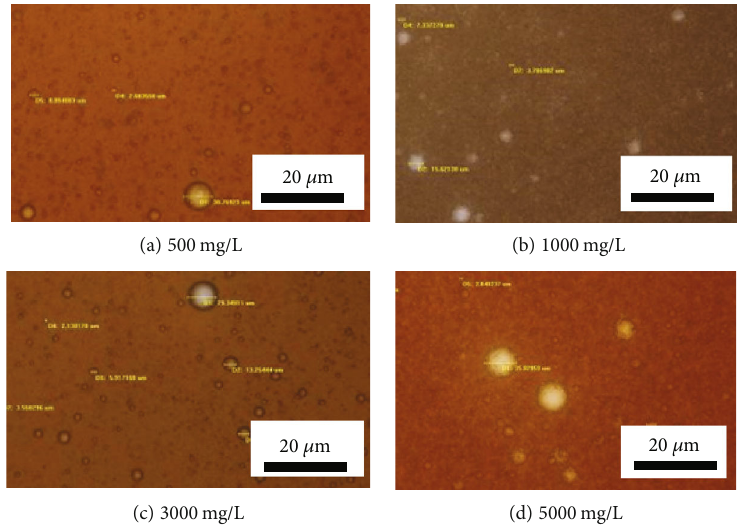
Figure 10: Microscope images of the emulsions obtained with di ff erent water salinities.